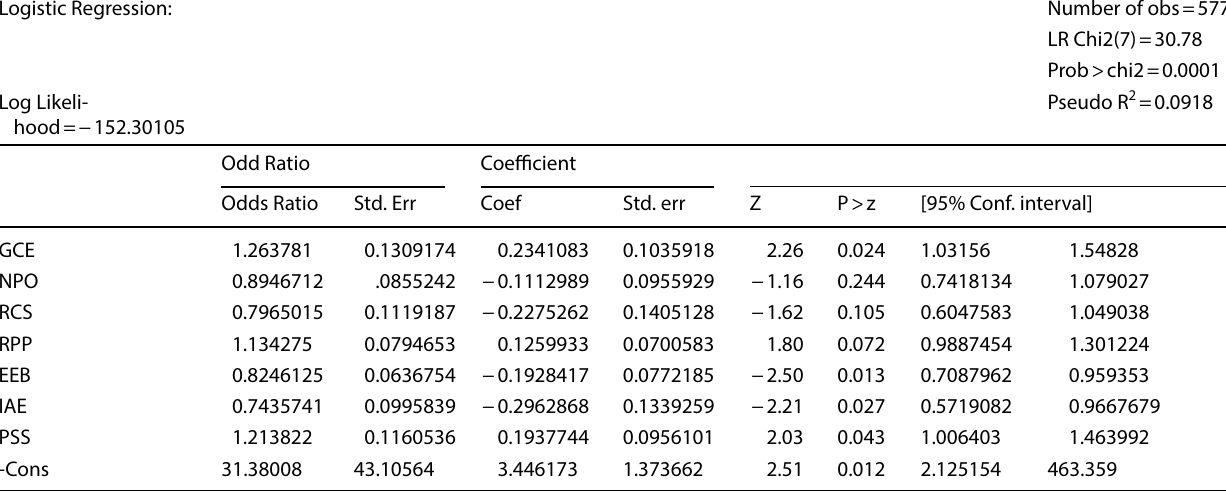
Table 6 Presentation of regression result